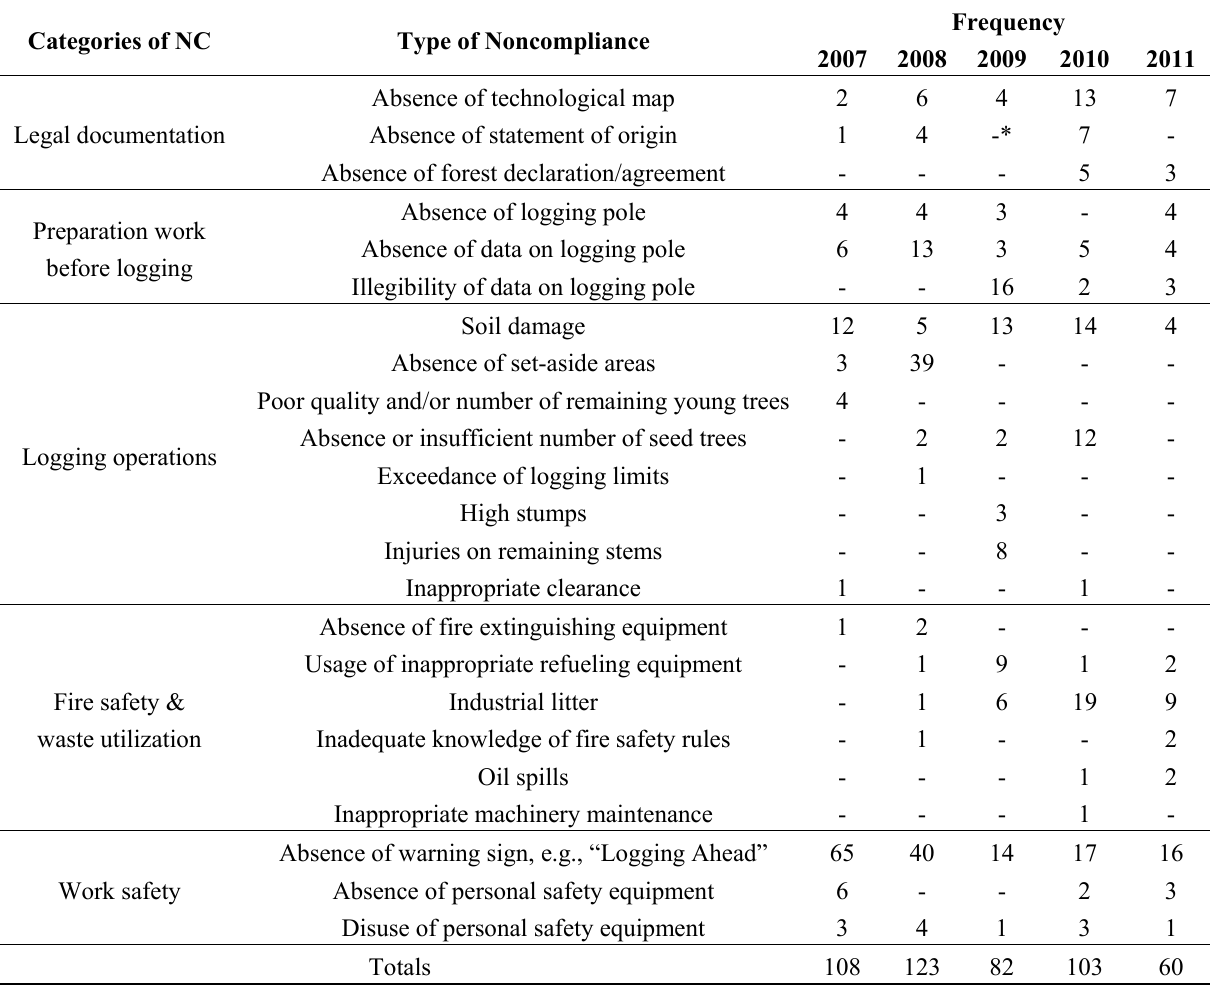
Table 8. Specification of noncompliance in relation to